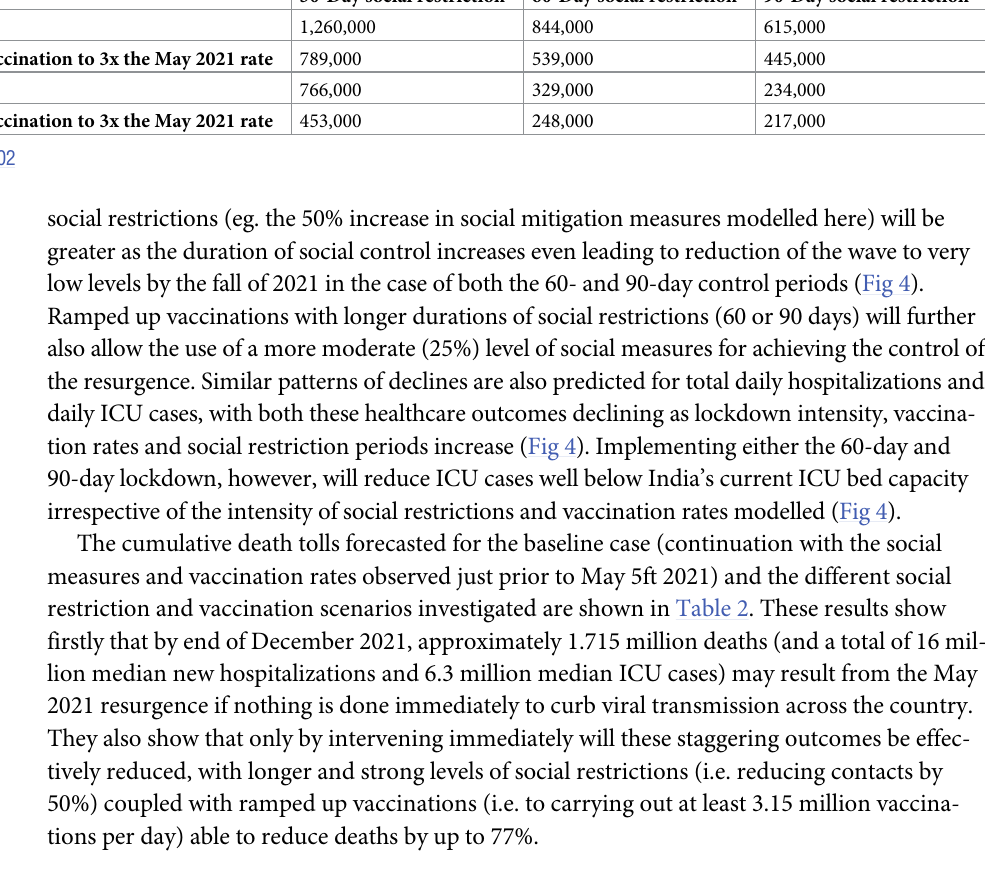
Table 2. Cumulative deaths due to COVID from May 5 th , 2021 to December 29, 2021 forecasted for various lockdown and vaccination scenarios. A: Baseline (current social measures and